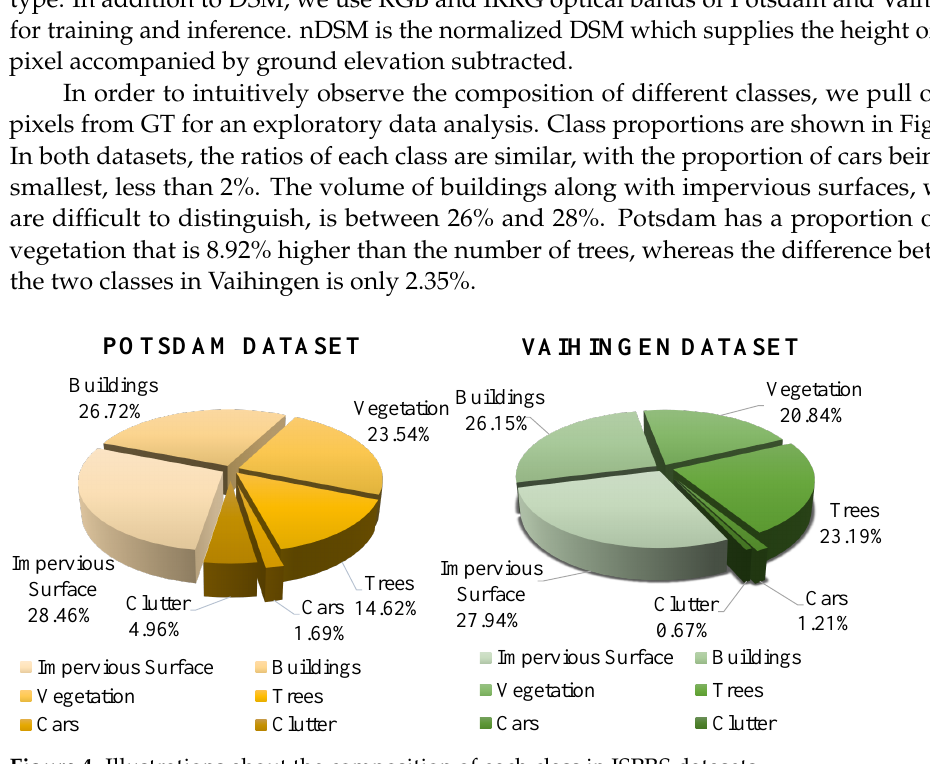
Figure 4. Illustrations about the composition of each class in ISPRS